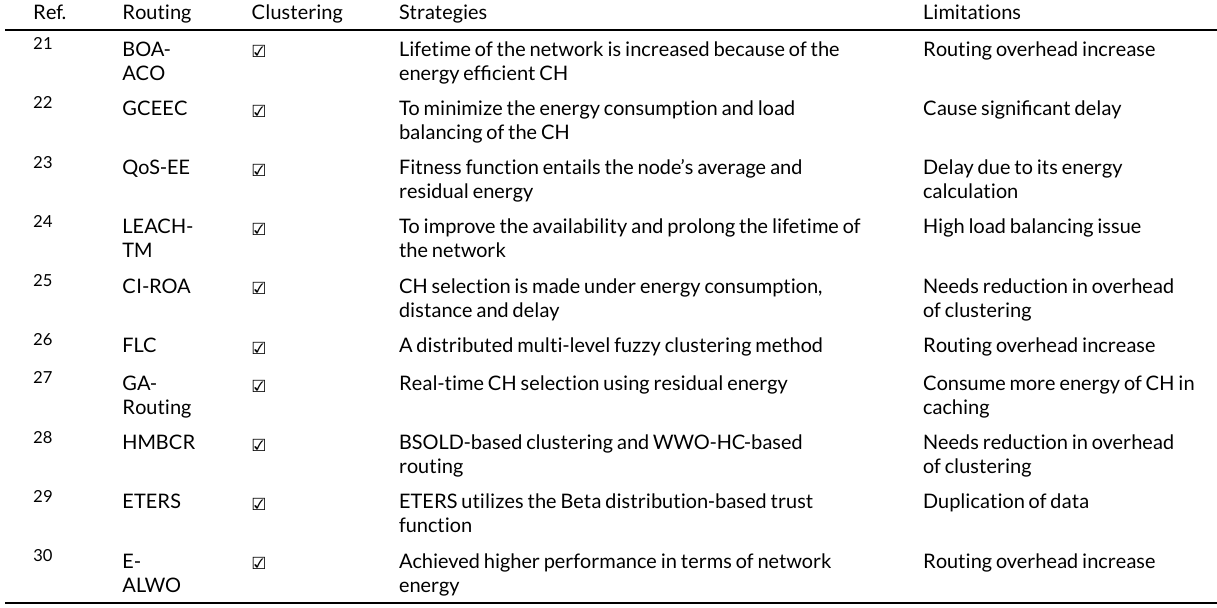
Table 1. Summary of Research Gap Ref.